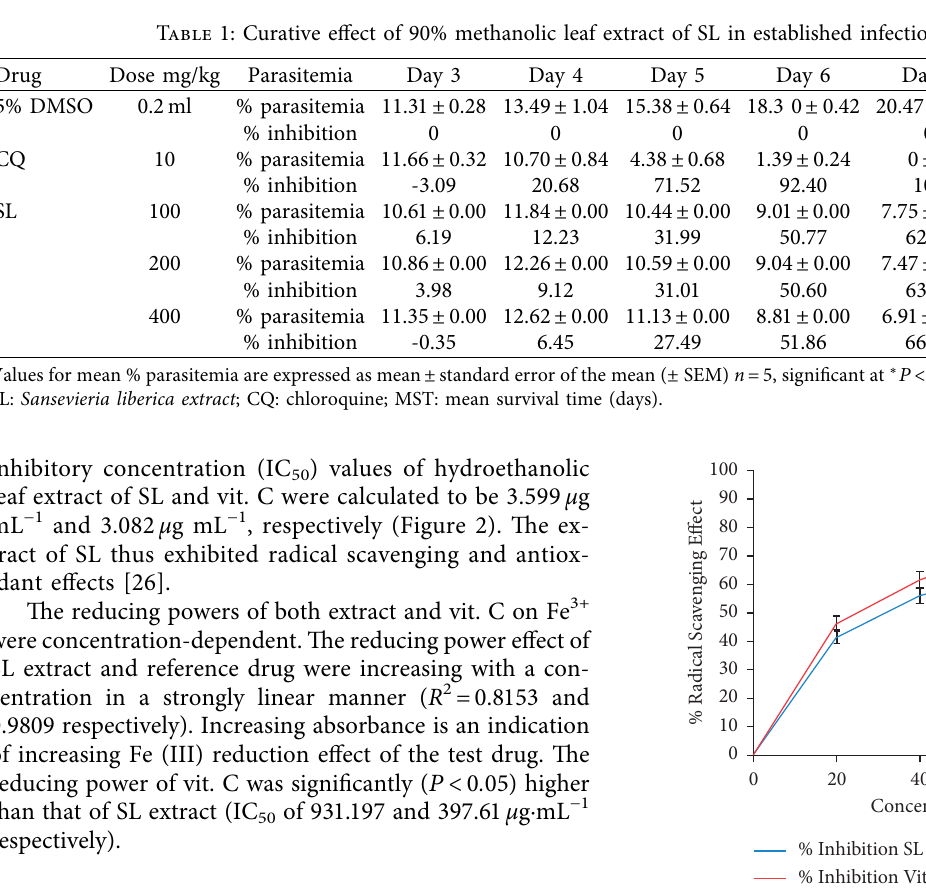
Figure 2: DPPH radical scavenging activities of SL and Vit. C SL: x � 3.599; R 2 � 0.7396. Vit. C x � 3.082; R 2 � 0.8131.